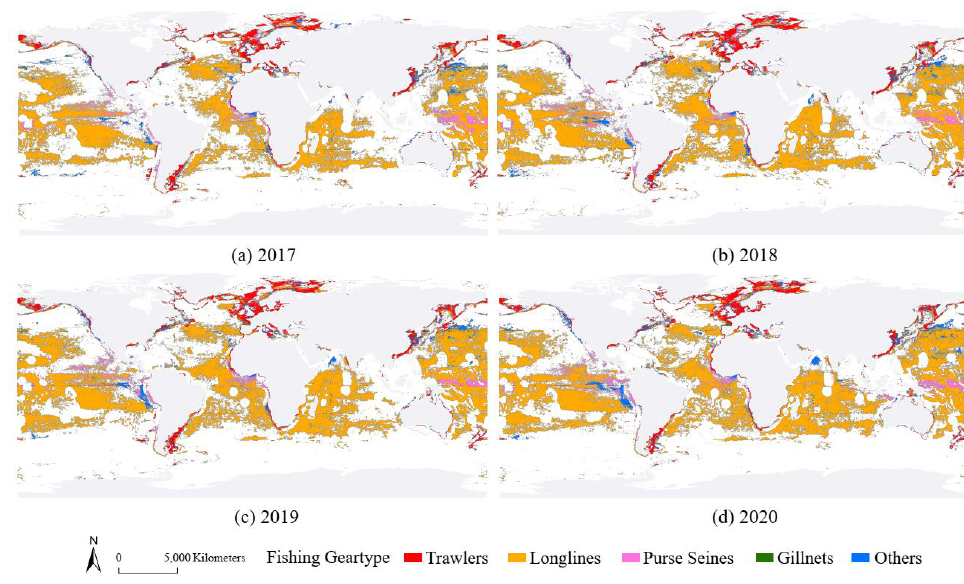
Figure 5. Spatial distribution of global fishing gear from 2017 to 2020. 177